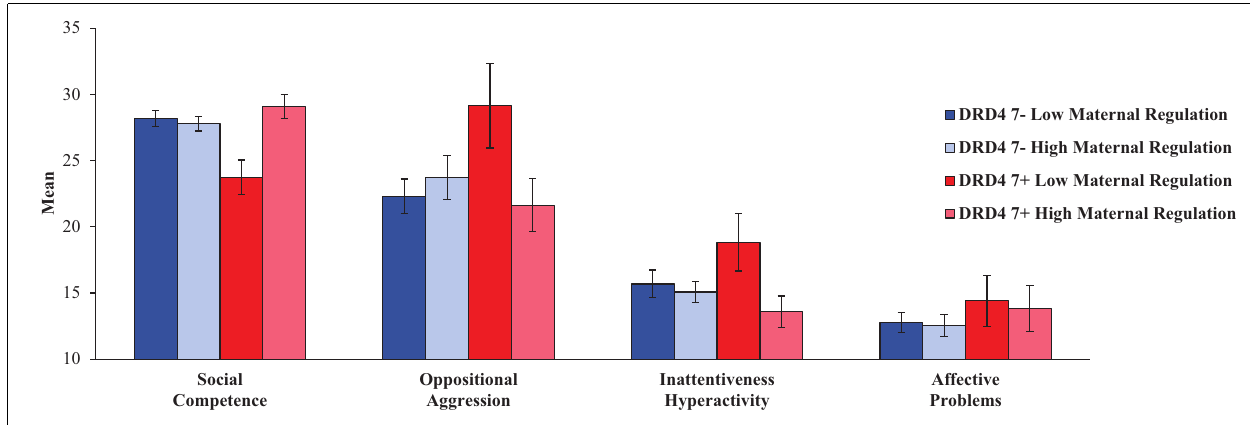
FIGURE 3 | Children’s Means (and SE) in social competence, oppositional-aggression, inattentiveness/hyperactivity, and affective problems according to DRD4 polymorphism and maternal regulation.